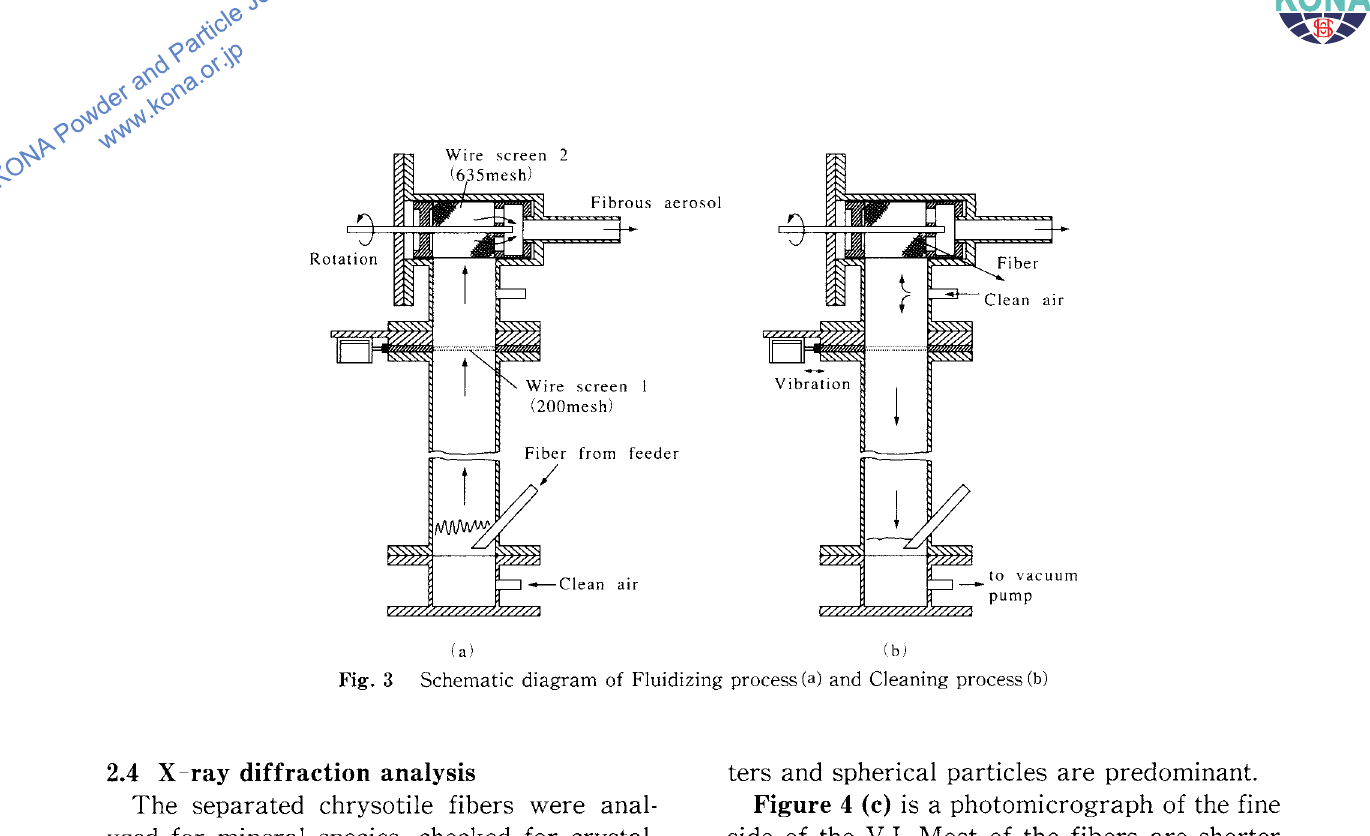
Fig. 3 Schematic diagram of Fluidizing process (a) and Cleaning process